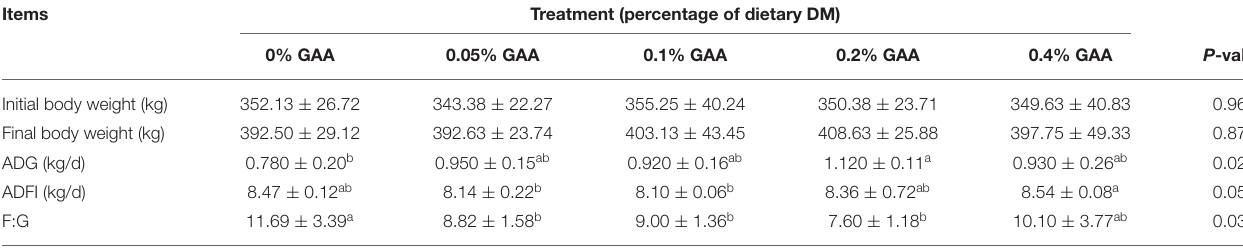
TABLE 2 | Effects of guanidinoacetic acid on growth and feed efficiency of Jinjiang bulls.